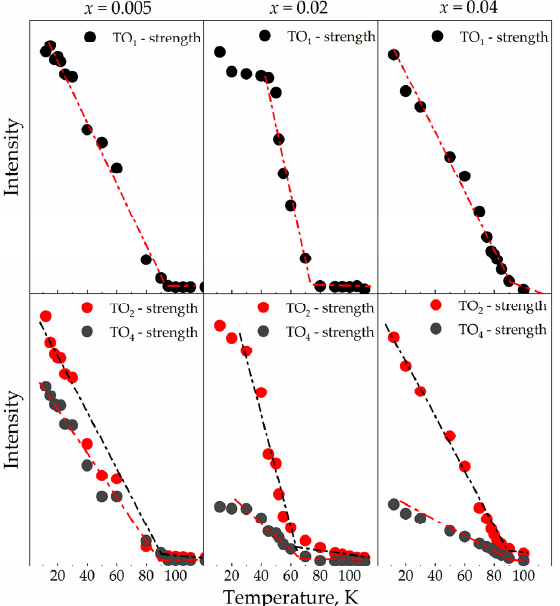
Figure 5. The temperature evolution of intensities of the TO 1 modes ( upper row ) and of the TO 2 and TO 4 modes ( bottom row ) for the Sr 1 − x Pb x TiO 3 solid solutions at x = 0.005, 0.02, 0.04. The dashed lines show the interpolation of the modes intensity.